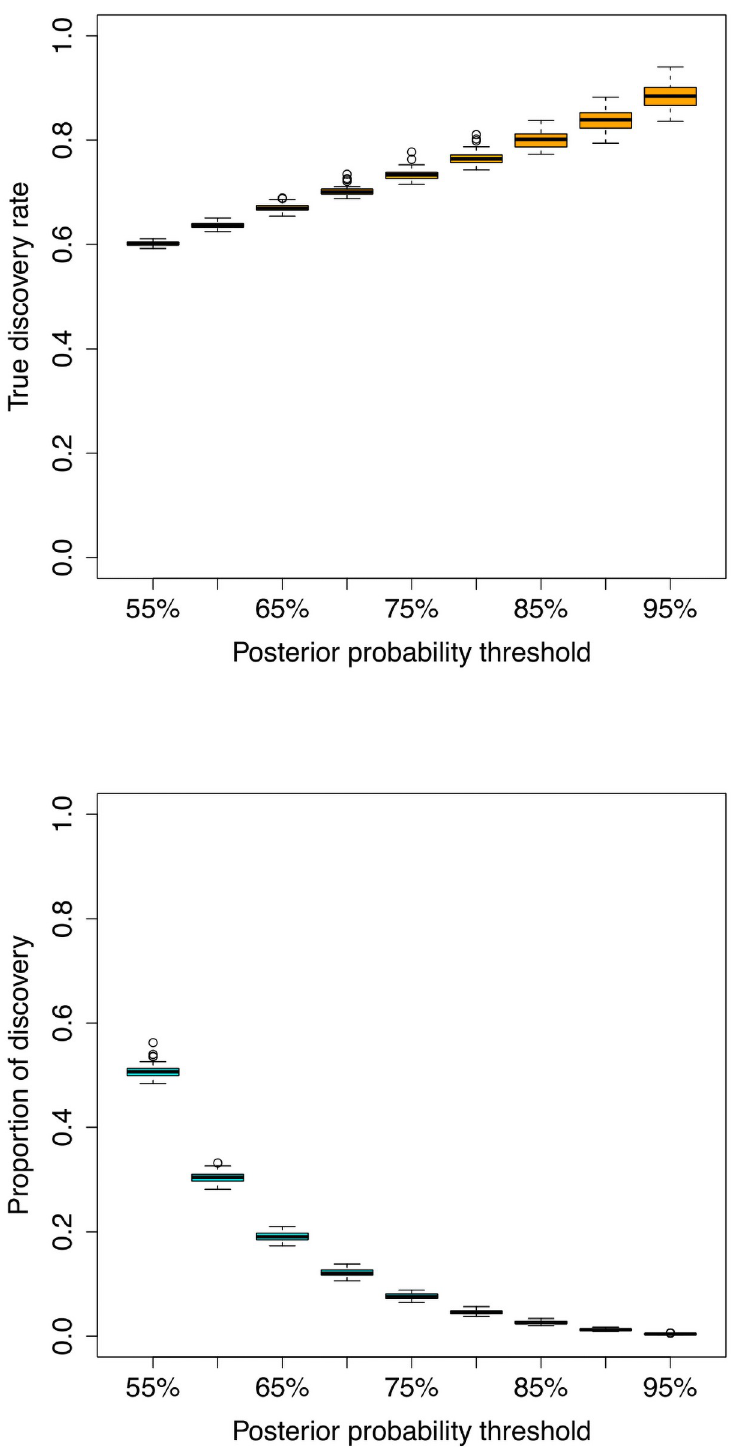
Fig 3. True discovery rate (TDR) and the proportion of discovery (POD) by eGST while classifying the tissue of interest across individuals at increasing thresholds of tissue-specific subtype posterior probability: 55%, 60%, 65%, ... , 90%, 95%. Box plots of TDR (top) and POD (bottom) across 50 datasets simulated under h 2 , m 1 = m 2 = 1000, n = 40, 000 are presented. Here h 2 w 1 ¼ w 2 ¼ 1 2 subtypes of the trait due to m 1 and m 2 SNPs representing two sets of tissue-specific eQTL SNPs, w 1 and w 2 are the proportions of individuals in the sample assigned to the two tissues, n is the total number of individuals.